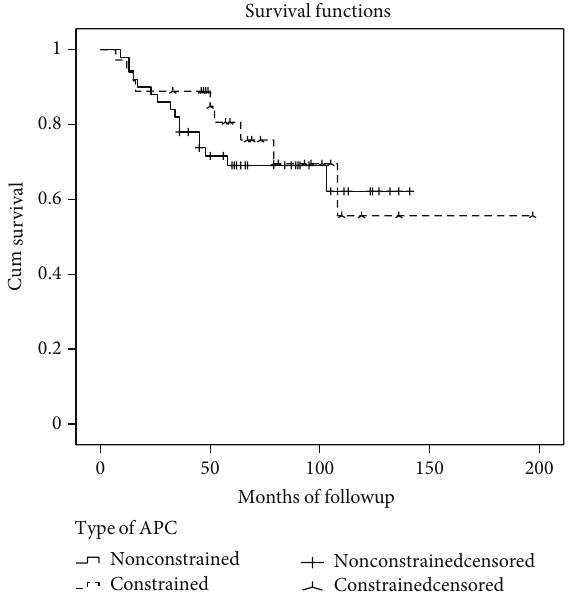
Figure 6: Kaplan-Meier curve showing the differences in APC survivorship between hinged and nonhinged knee